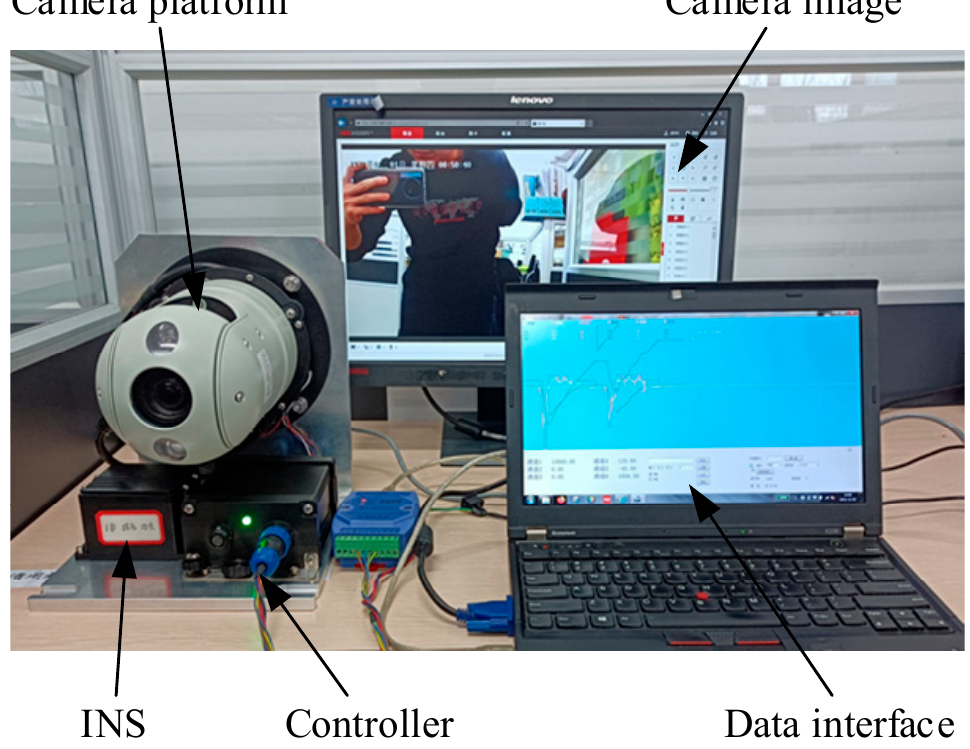
Figure 11. Devices of the camera stabilized platform experiment for testing. Table 5. The elements and interface of the modules that compose the camera stabilized platform.